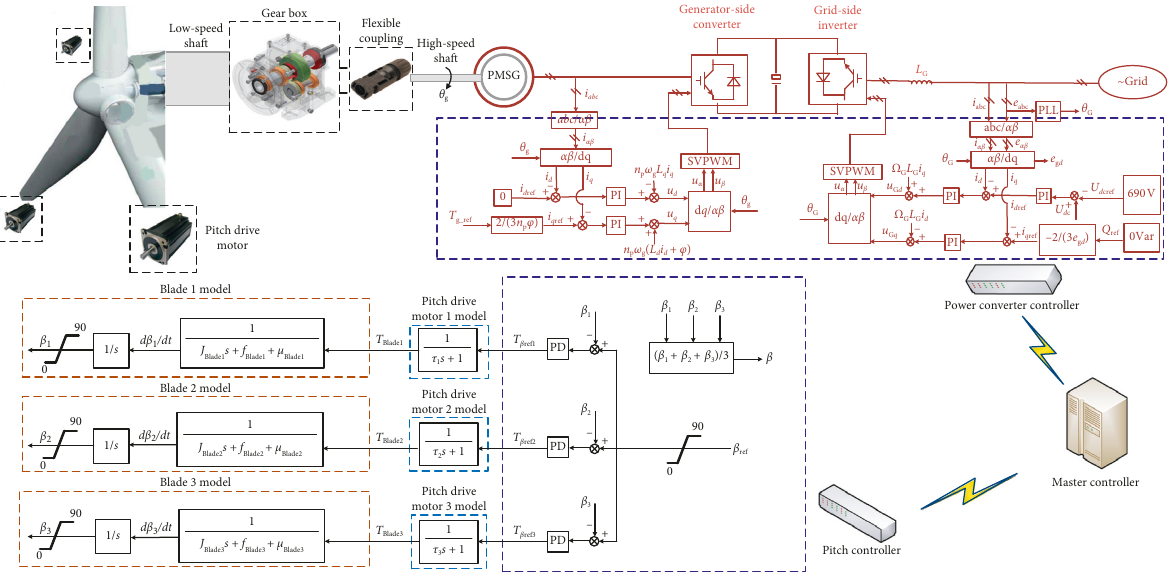
Figure 15: Block diagram of WECS.